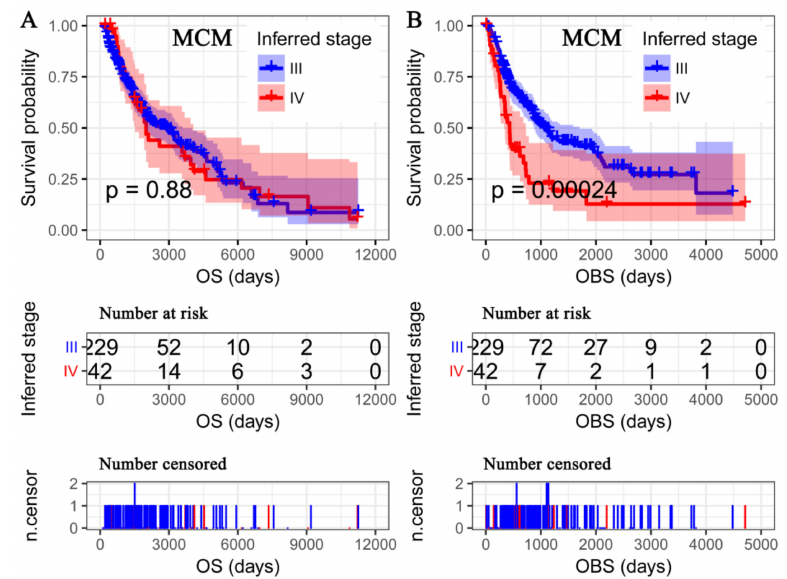
Figure 3. Kaplan-Meier survival analysis of inferred pathological stage. The OBS and inferred pathological stage in TCGA-MCM cohort ( A ), OS and inferred pathological stage in TCGA-MCM cohort ( B ). OS—overall survival; OBS—observed survival interval.